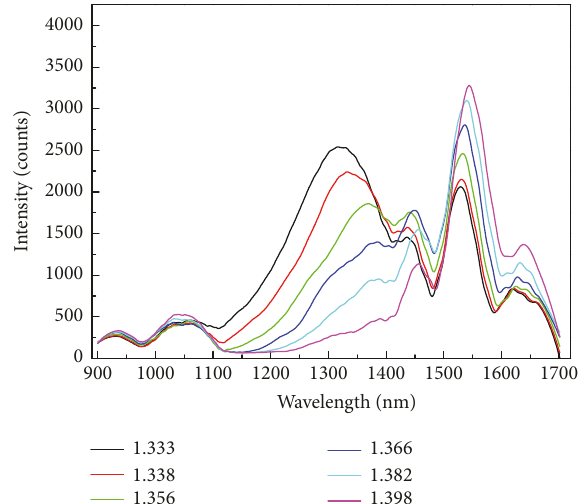
Figure 5: The transmittance spectra of different refractive index solutions by D-LMR optical fiber